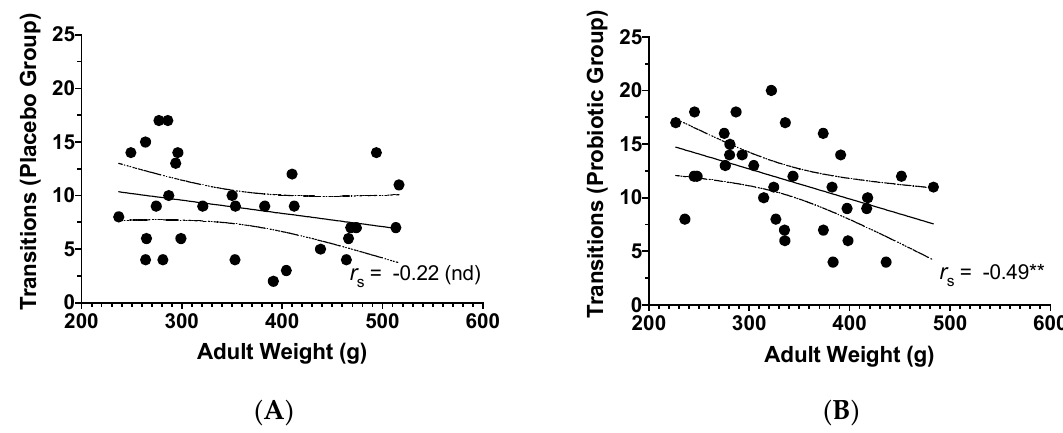
Figure 9. Scatterplot of the relationship between adult weight (g) and: ( A ) Transitions during light–dark box testing in placebo animals; ( B ) Transitions during light–dark box testing in probiotic animals. ** p < 0.01; nd: no difference; including 95% confidence bands of the best fit lines.